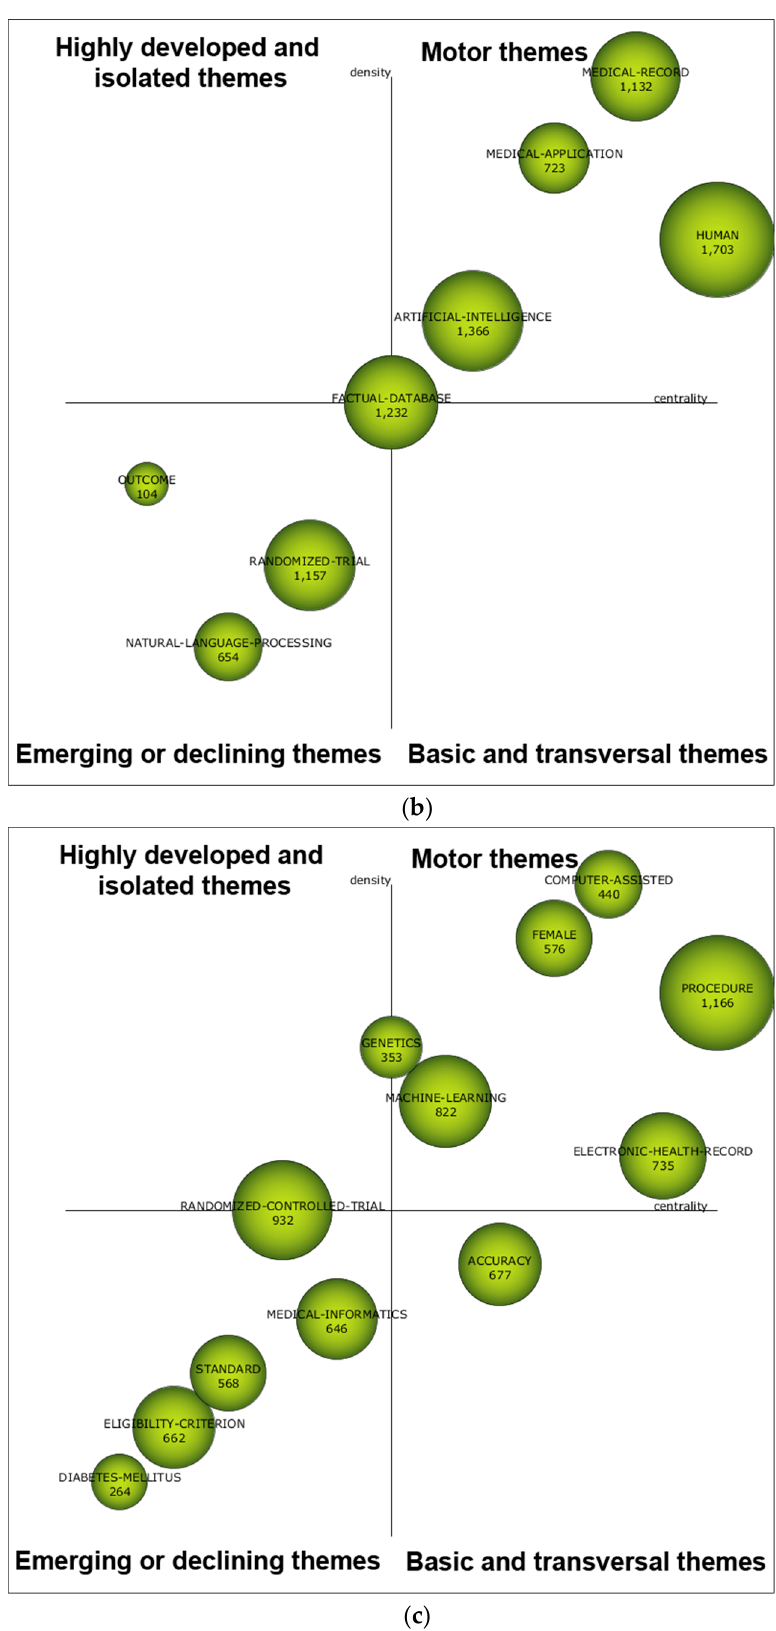
Figure 5. Strategic diagram for the periods 1999–2008 ( a ), 2009–2013 ( b ), and 2014–2018 ( c ).